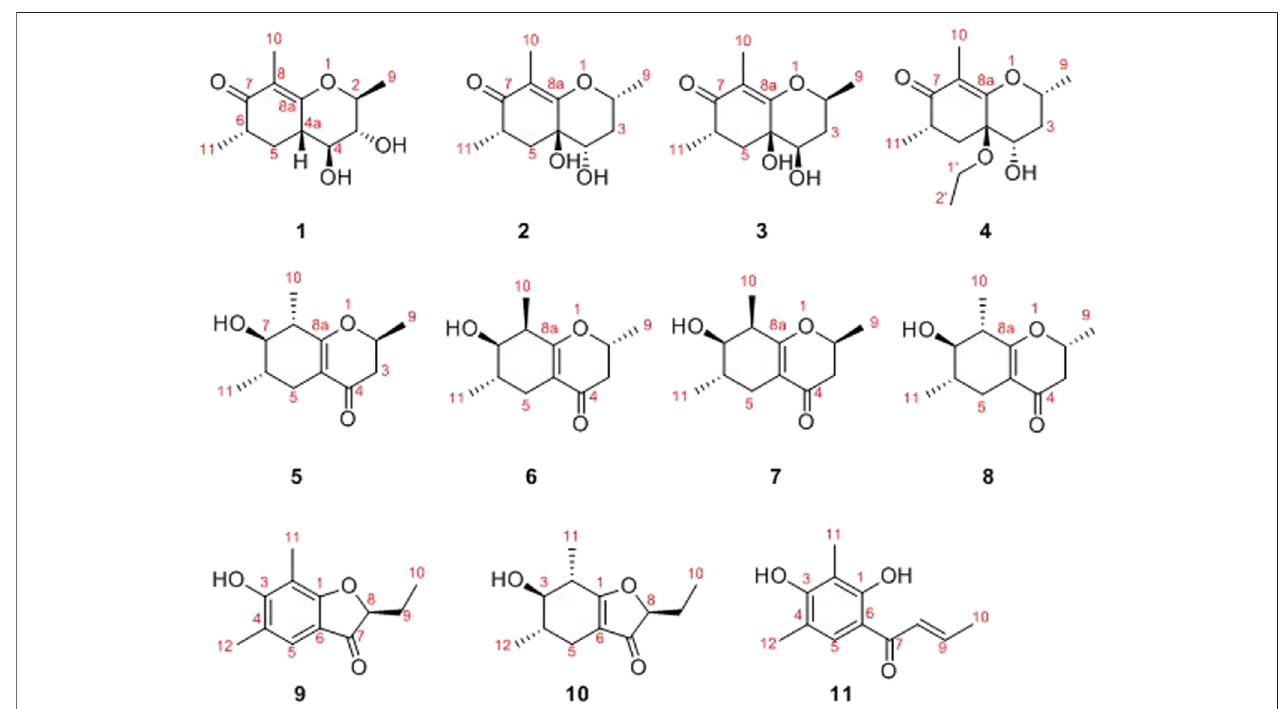
FIGURE1 | Structures of compounds 1 –